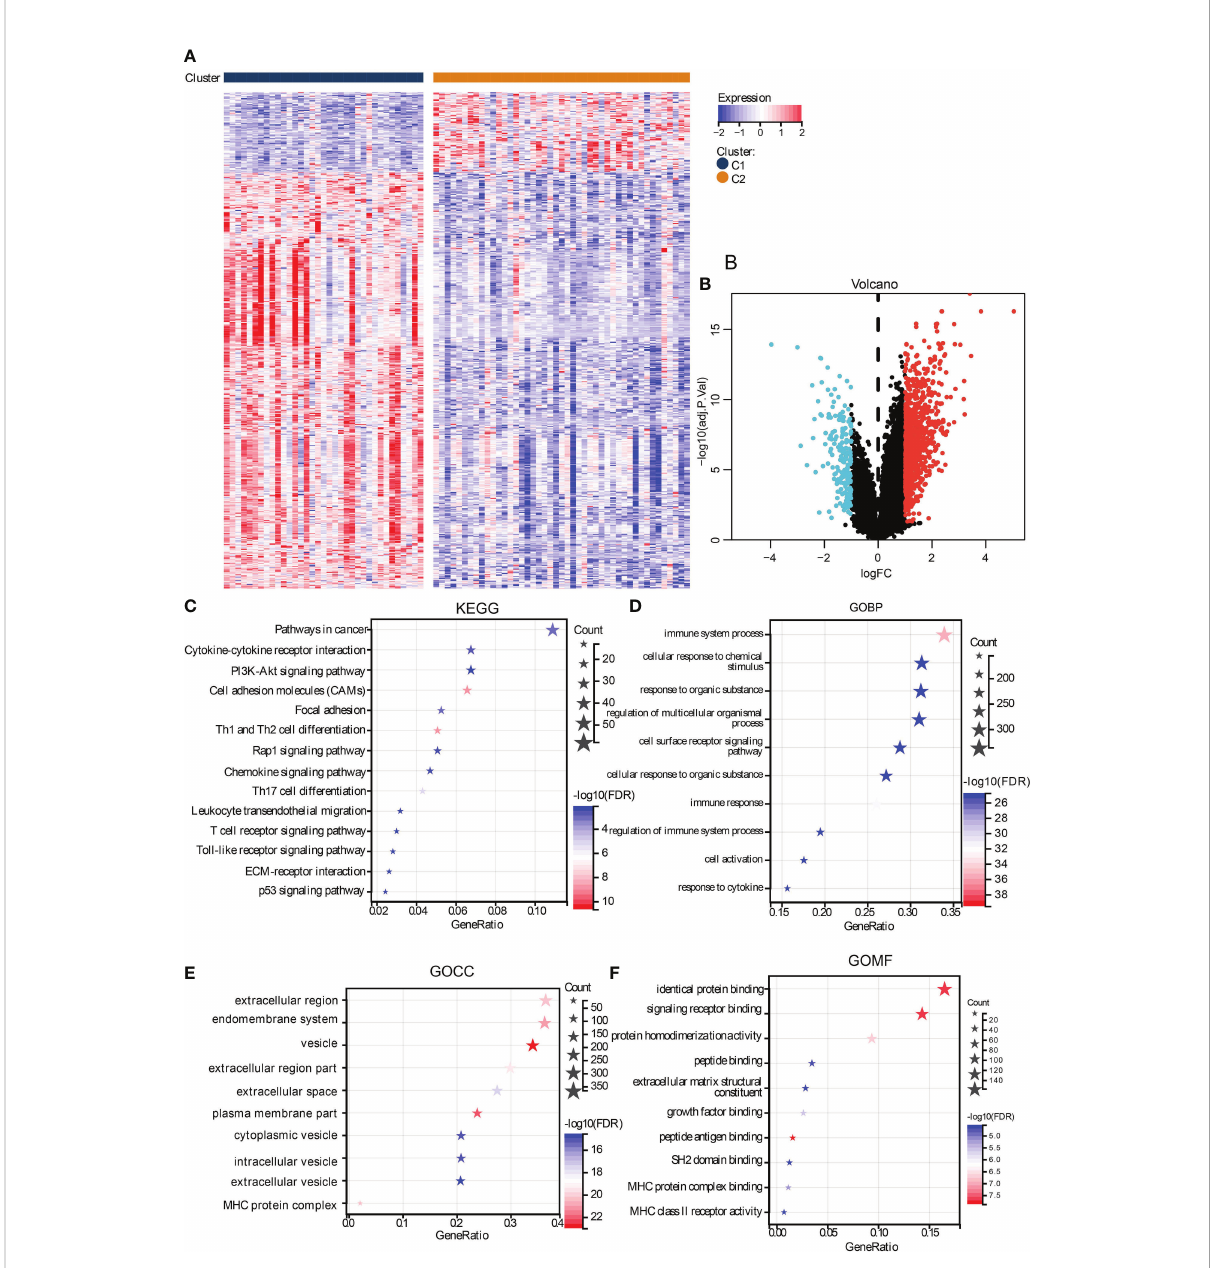
FIGURE 4 Functional analysis of DEGs between subtypes. The heat map (A) and volcano plot (B) shows the DEGs between subtypes. The functional analysis results were presented in bubble plots presenting the enriched KEGG (C) , GOBP (D) , GOCC (E) , and GOMF (F) , gene